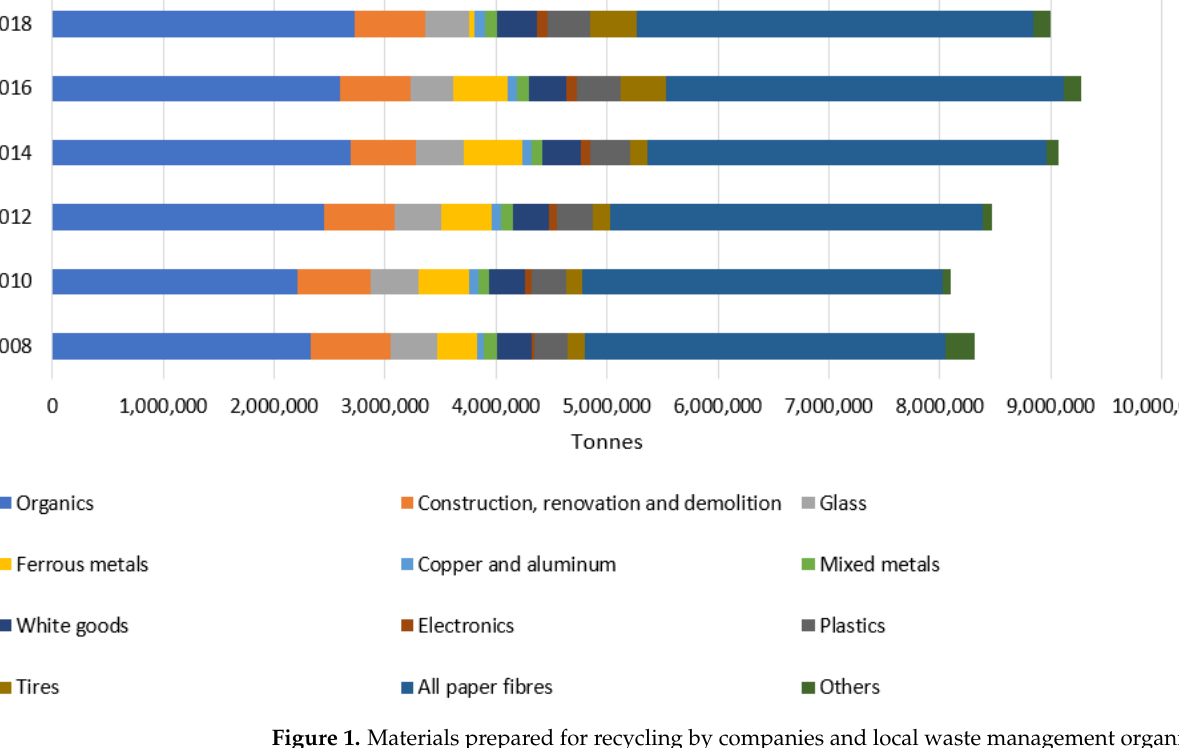
Figure 1. Materials prepared for recycling by companies and local waste management organizations in Canada. The authors originally produced the figure from Canada’s national statistical agency [9].